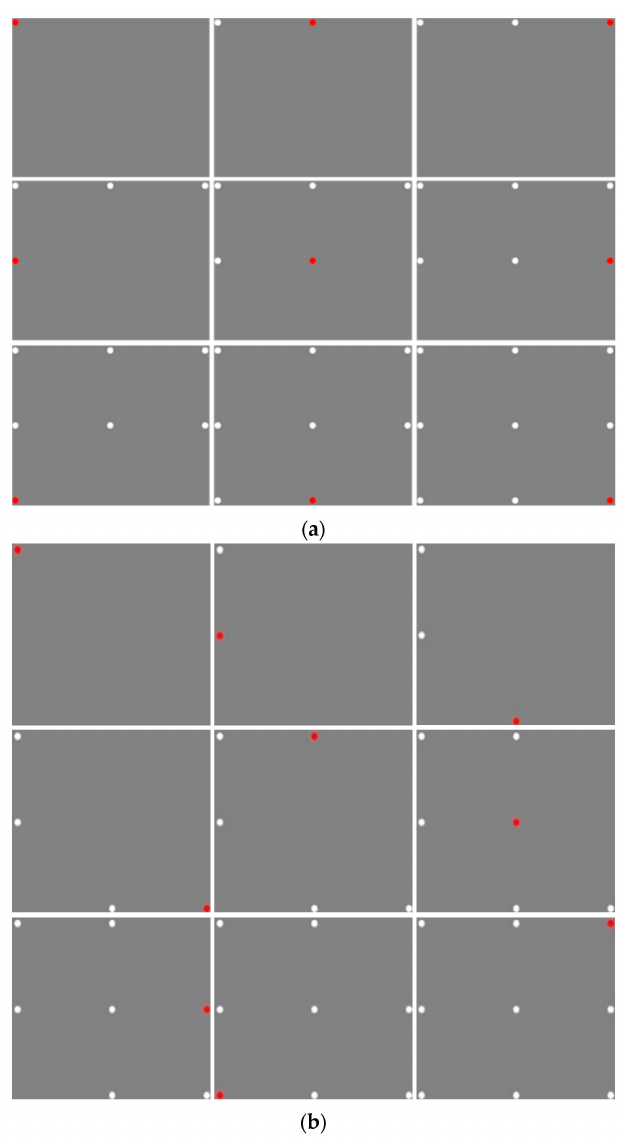
Figure 12. Various calibration marker types: ( a ) static and ( b ) dynamic markers.